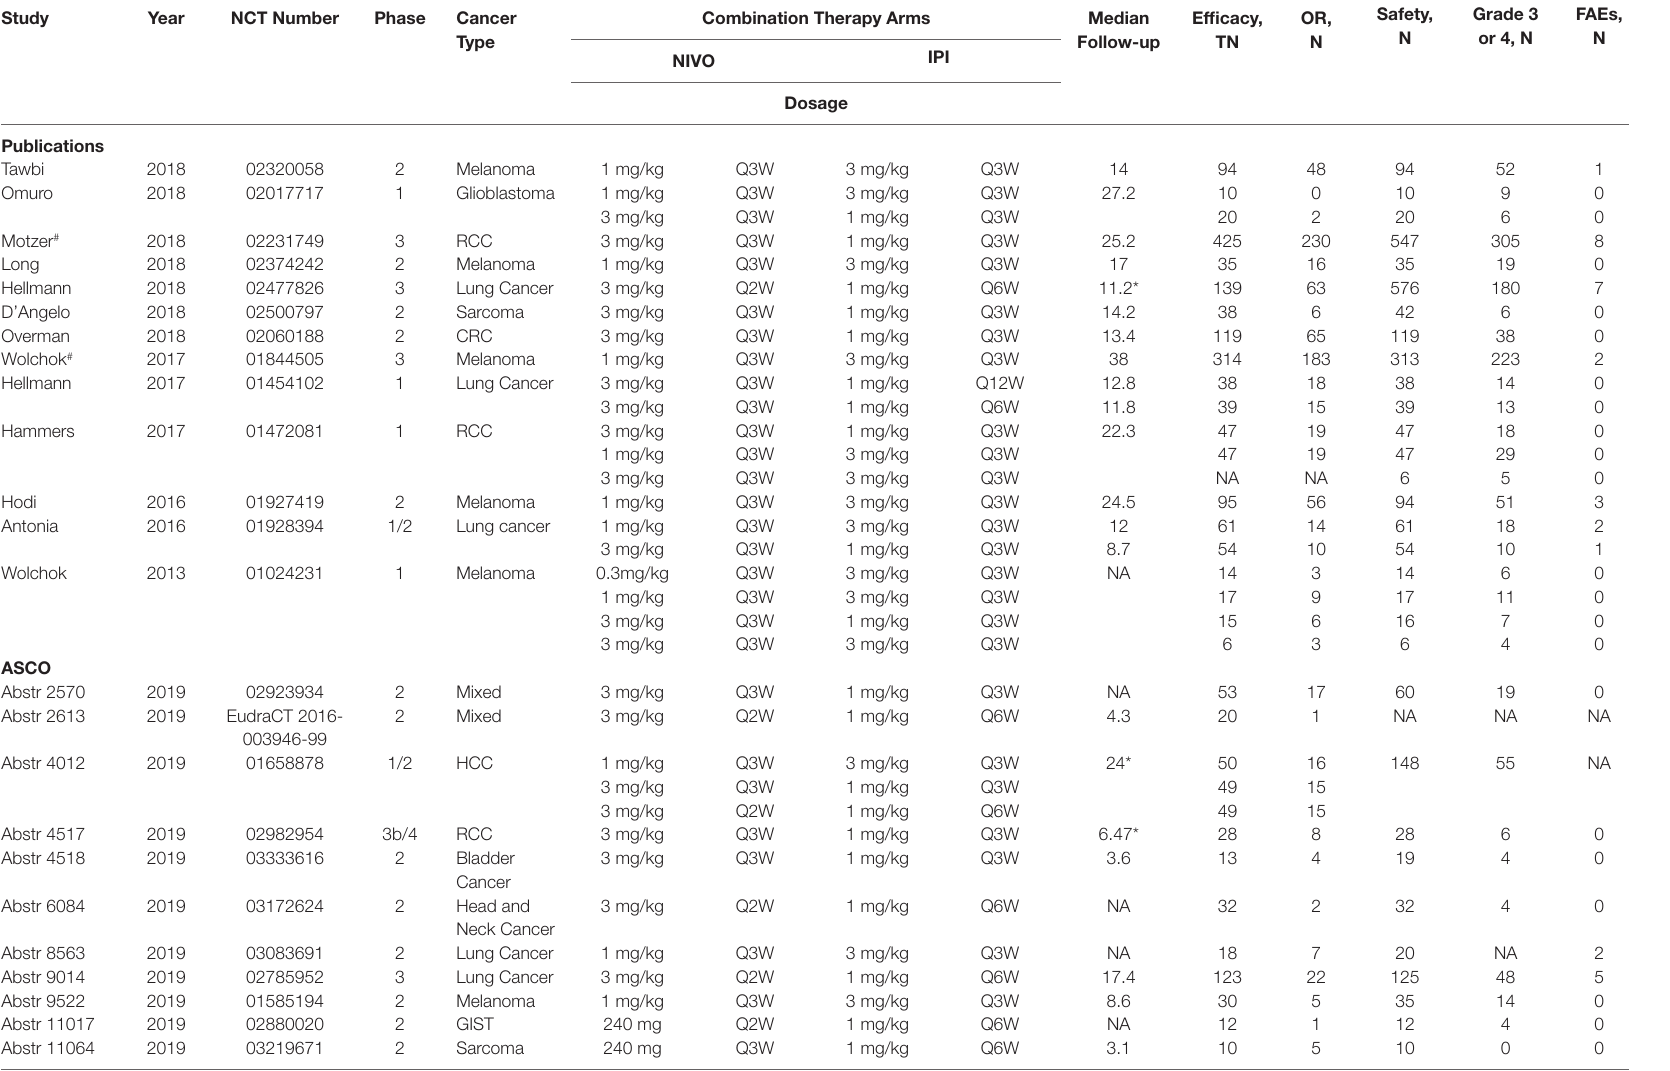
TABLe 1 | Baseline characteristics of trials included in this